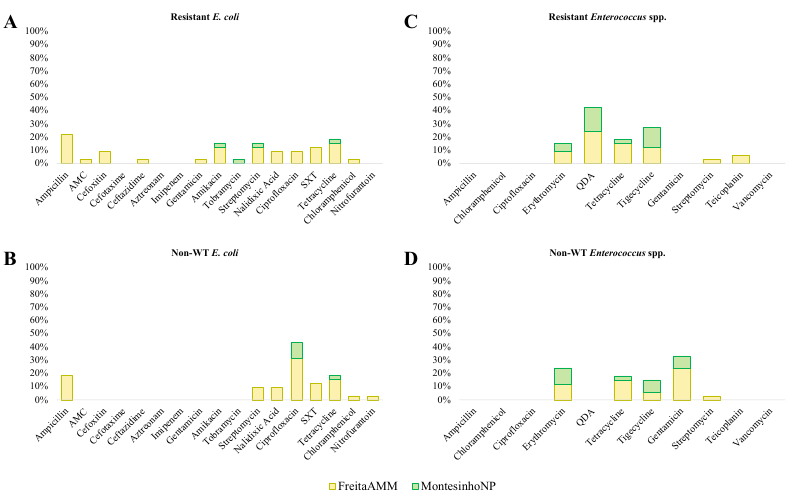
Figure 5. AST results for E. coli and Enterococcus spp. isolated in the present study, interpreted with clinical breakpoints (resistant strains; ( A , C )) and ECOFFs (non-wildtype strains; ( B , D )). AMC, amoxicillin/clavulanic acid; SXT, trimethoprim–sulfamethoxazole; QDA, quinupristin–dalfopristin. According to the ECOFFs calculated with the NRI [28], 50% ( n = 16) of the E. coli were NWT for at least one of the antibiotics tested and mainly to quinolones, β -lactams, and tetracycline (Figure 5B, Table S4). This is a higher rate than observed in red foxes from Norway (8%), where E. coli were mostly resistant to sulfamethoxazole, ampicillin, and tetracycline [19]. For instance, in the last 12 years in Portugal, the consumption